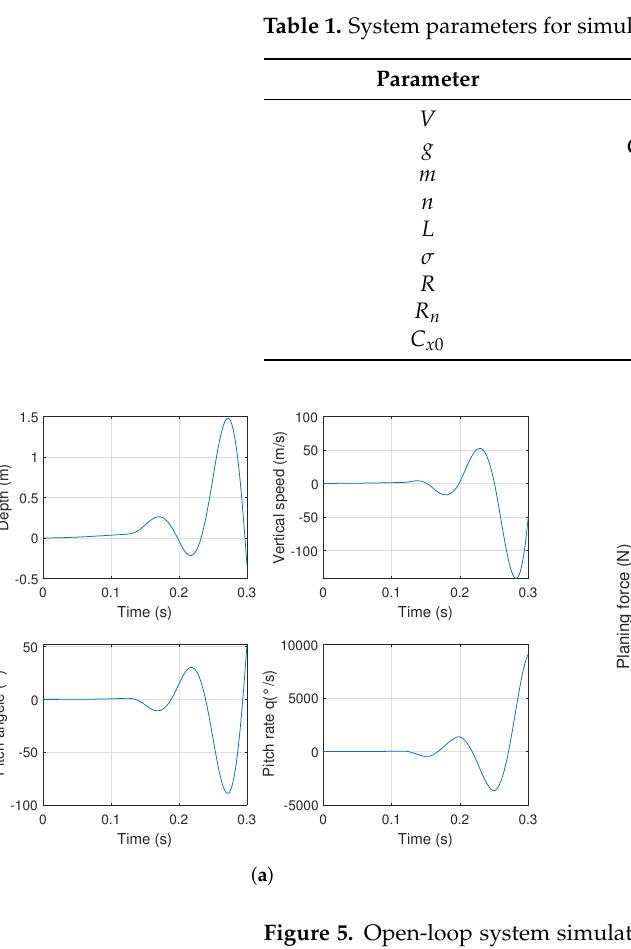
Figure 5. Open-loop system simulation: ( a ) Four states of open-loop system; ( b ) Planing force of open-loop system.